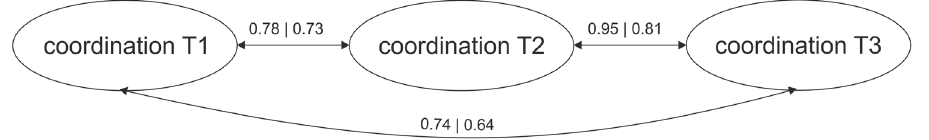
Figure 1. Simplified model for coordination ( χ 2 = 56.742; df = 39; p = 0.033; CFI = 0.996; RMSEA = 0.017). 1: 2003–2006; T2: 2009–2012; T3: 2014–2017. df degrees of freedom, CFI Comparative Fit Index, RMSEA root mean square error of approximation, ADHD attention deficit hyperactivity disorder. The first value before the vertical bar refers to the values in the ADHD group, while values after the vertical bar apply to the non-ADHD group. The presented results are based on the multi-group model with completely fixed factor loadings and intercepts over both groups as well as the restrictions over the measurement points according to the partial scalar measurement model over time.